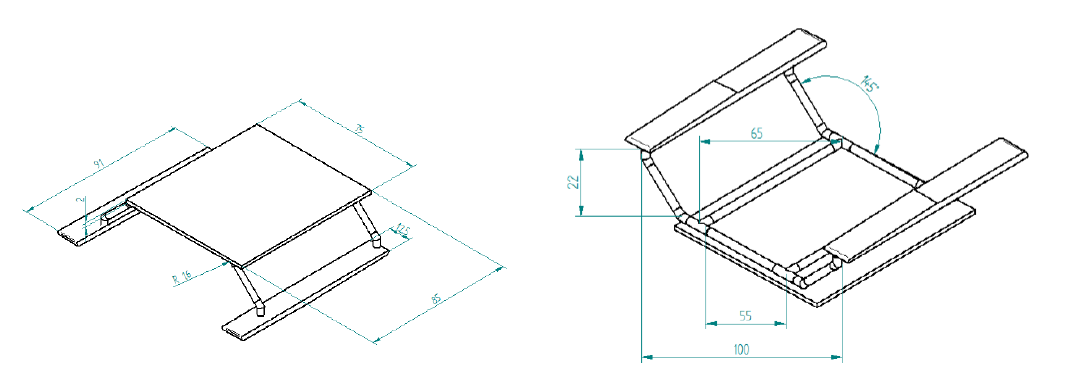
Figure 2. Top and bottom view of the CAD